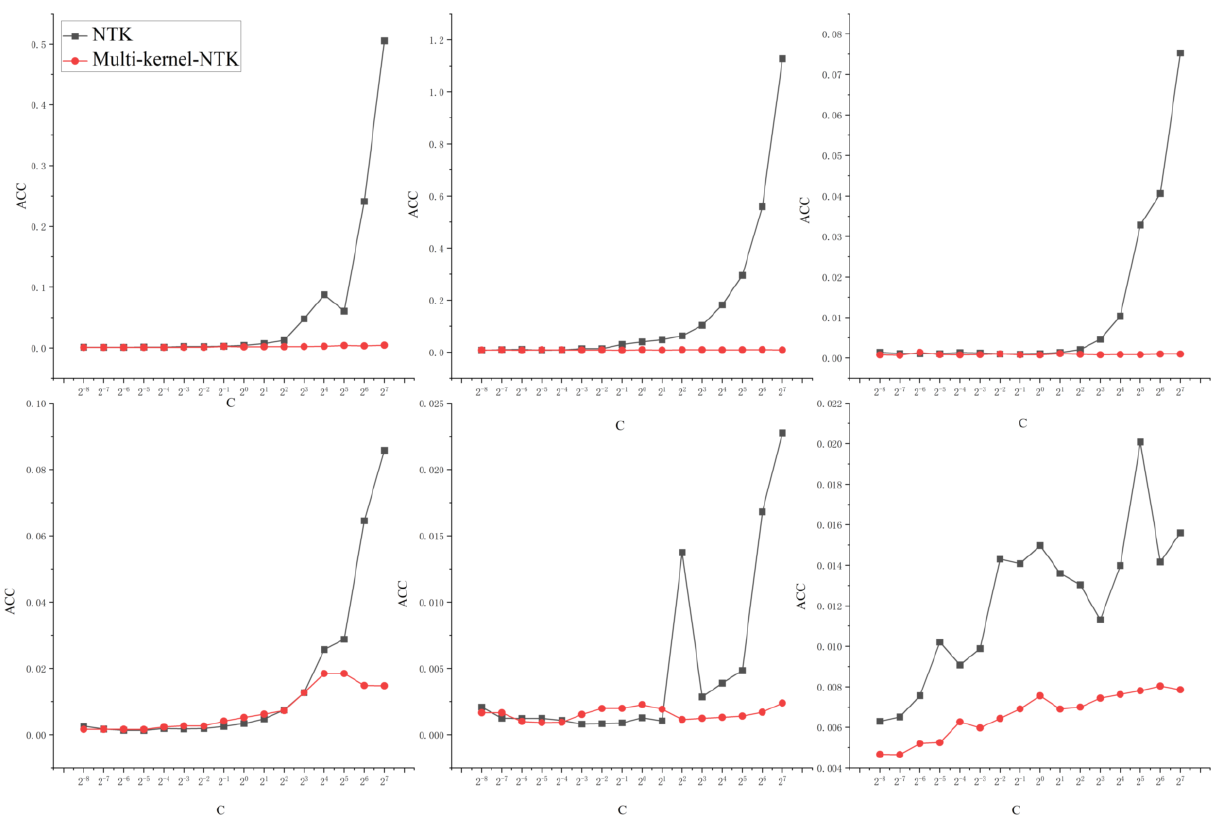
Figure 4. Effect of penalty parameter C on the training time of the model. The red line represents the trend of the multi-kernel-NTK model with C, and the black line represents the trend of the original NTK model with